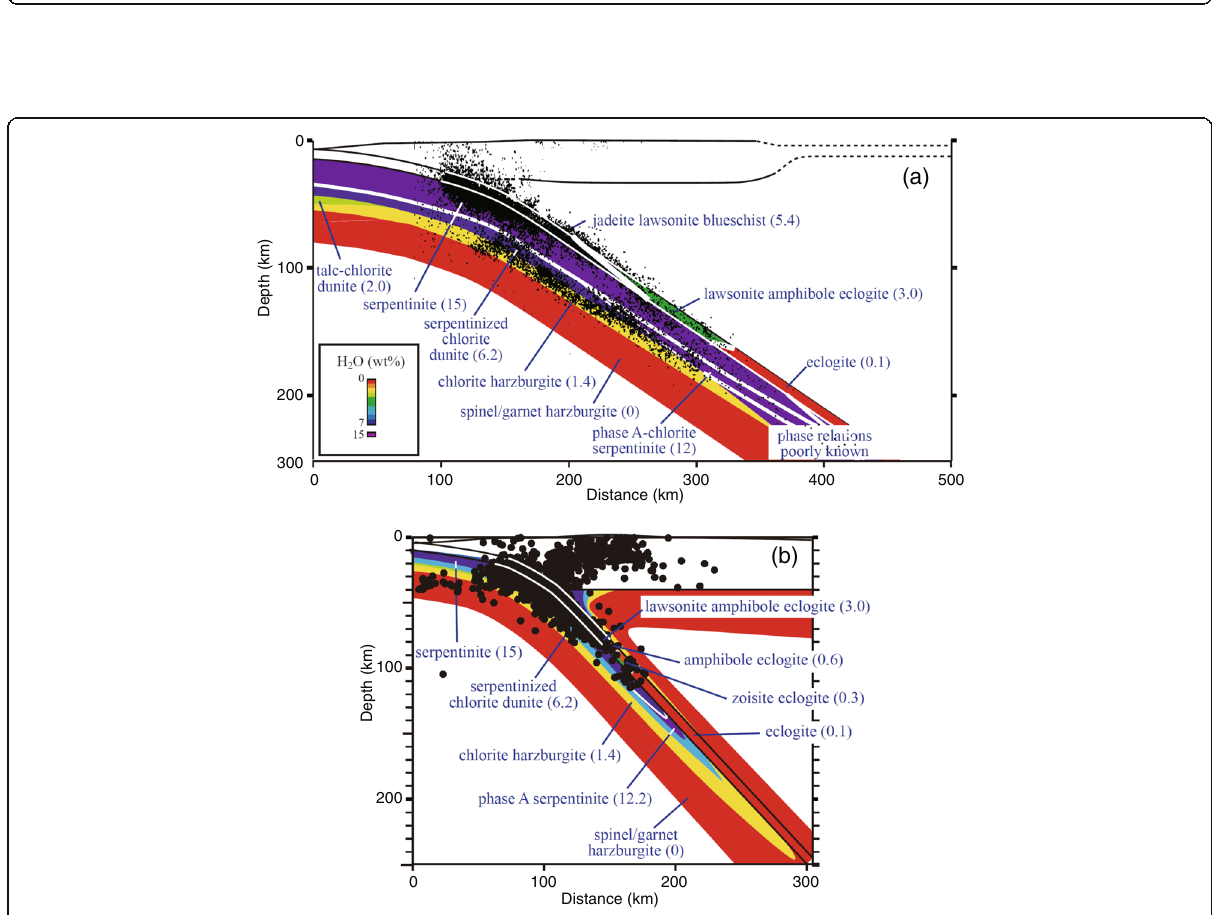
Fig. 4 Across-arc vertical cross-sections of intraslab seismicity and existence range of hydrous minerals in the slab. a Tohoku and b Costa Rica subduction zones. Maximum H 2 O contents are shown by the color scale. Dots show earthquakes. (After Hacker et al.